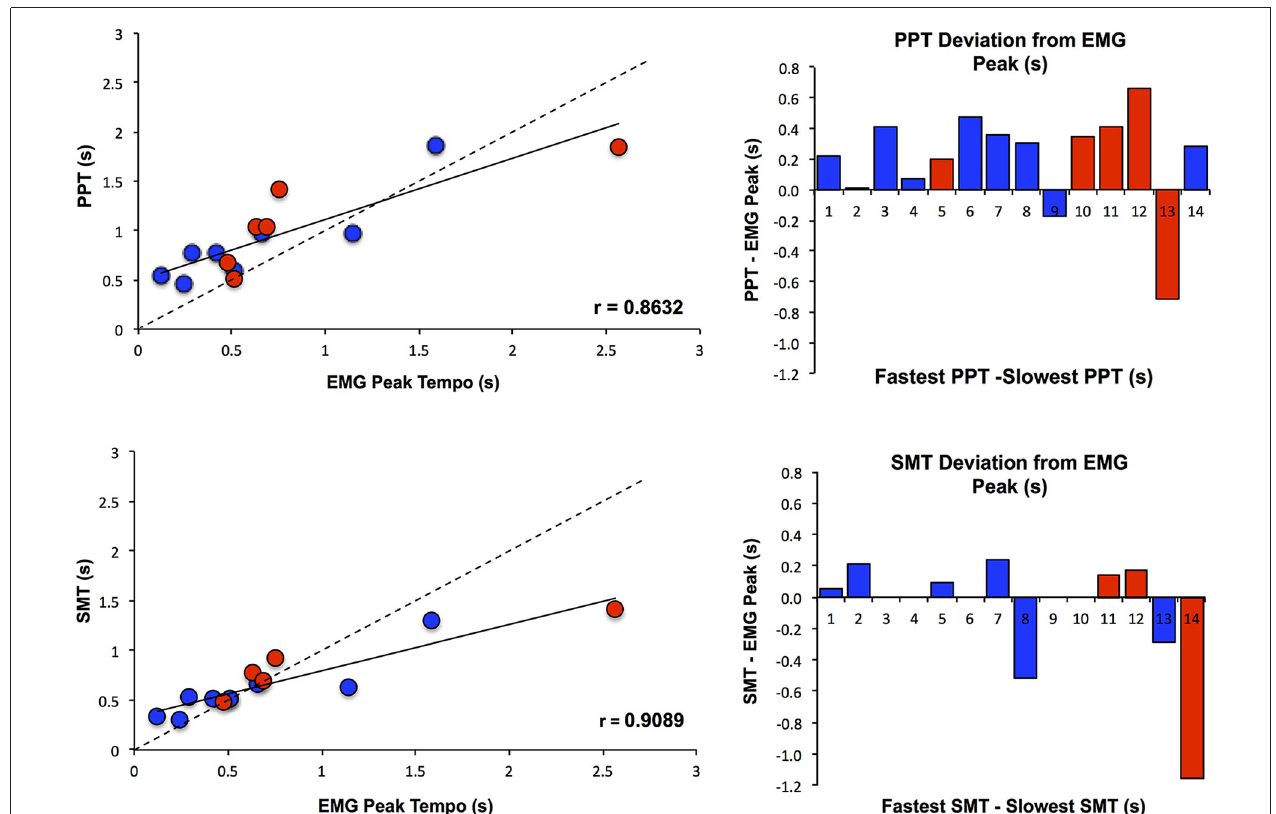
color coded according to whether they showed an increase in MEPs when listening to PT (Excitation Pattern, shown in red) or a decrease in MEPs when listening to PT (Suppression Pattern, shown in blue). SMT, PPT and EMG Peak values are displayed as seconds between